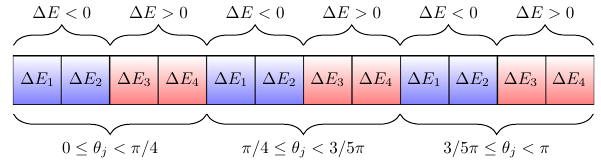
Fig. 3 Concatenation of optimised event rates N opt (θ j ,(cid:5) E ) in three bins of θ j , [ 0 ,π/ 4 , 3 π/ 5 ,π ] , and four bins in (cid:5) E , [−∞ , − 100 , 0 , 100 , ∞] GeV. For each bin in θ j , the bins coloured blue have (cid:5) E < 0, while the bins coloured red have (cid:5) E > 0. The binning is used both at the reconstruction level R and truth level